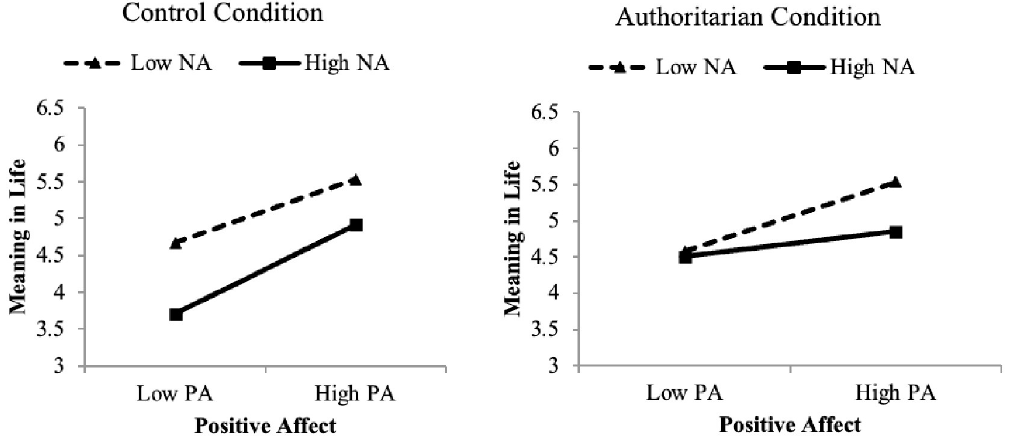
Fig 5. Positive affect X negative affect predicting meaning in life, in control and authoritarian